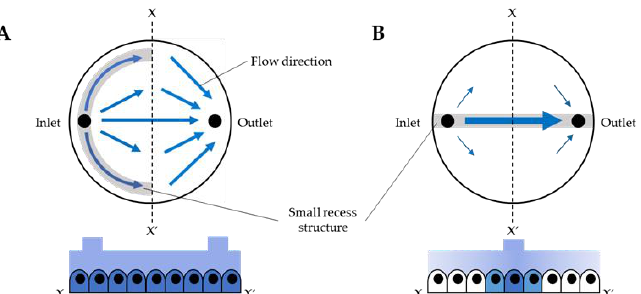
Figure 1. Flow control in the closed environment of a culture dish. By providing a structure that can control flow in a culture dish by adapter selection, it is possible to arbitrarily modulate the liquid flow in the closed environment without changing the culture medium, culture dish, or injection rate. ( A ) Delivered liquid flows uniformly from the inlet towards the outlet at an almost constant speed irrespective of the position in the culture dish. Cells in culture dishes can be stably cultured under the same conditions. ( B ) Delivered liquid flows linearly from the inlet to the outlet. A concentration gradient occurs in the culture dish along the flow of the delivered liquid, and, as a result, it is possible to modulate its influence on cells by adapter selection.